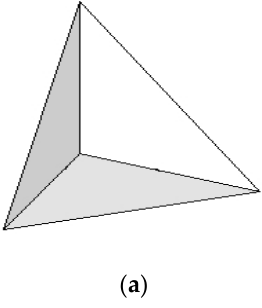
Figure 2. ( a ) Trihedral, ( b ) co-pol and ( c ) cross-pol polarimetric signatures characterizing scattering.